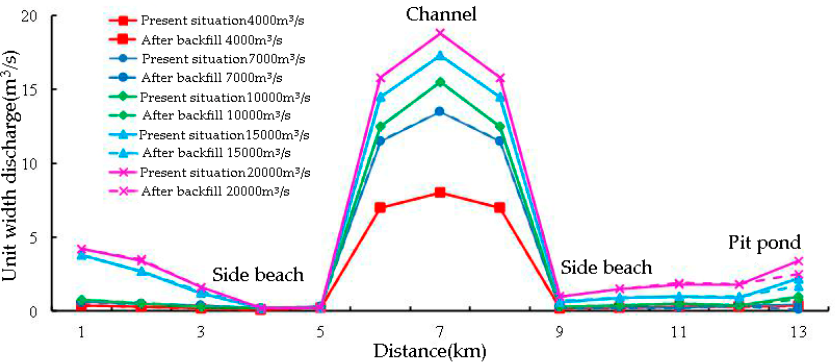
Figure 12. Single width flow distribution of the 167 cross-section.